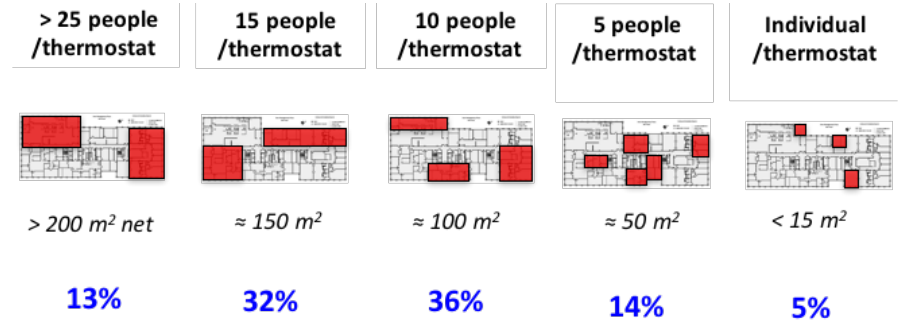
Figure 4. Distribution in Size of thermal zone for 1155 questionnaire respondents in 64 buildings.